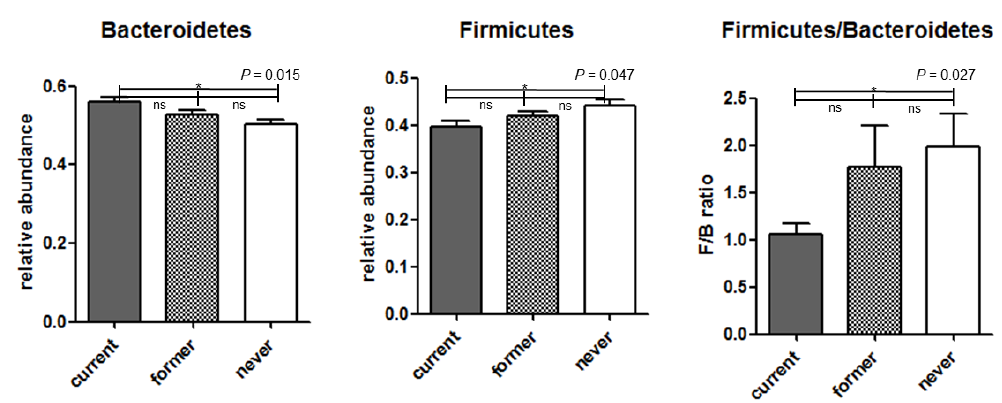
Figure 4. Comparison among groups of phylum Bacteroidetes and phylum Firmicutes with high gut microbiota composition. ns, non-significant; *, true values in analysis of composition of microbiomes.